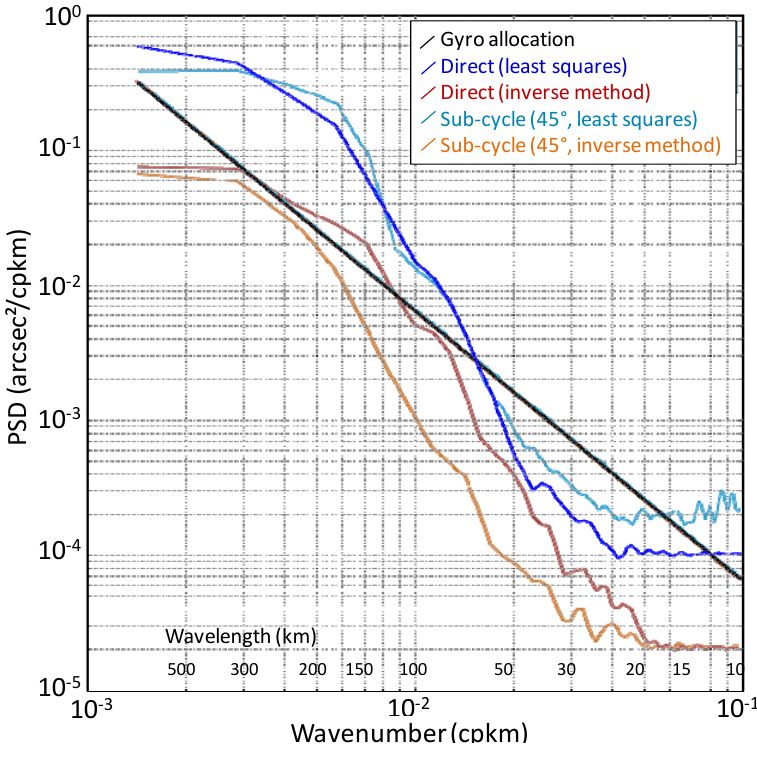
Figure 11. Usage of nadir altimetry and inverse methods to mitigate leakage of oceanic variability in roll. The dark blue PSD shows how much ocean variability is absorbed as apparent roll when unweighted least squares and the total topography are used in the direct method, and the red PSD shows the same results with an inverse method and a nadir constellation proxy. The cyan PSD shows how much ocean variability is absorbed as apparent roll when unweighted least squares and the total topography are used in the sub-cycle method (latitude of 45°), and the orange PSD shows the same result with an inverse method and a nadir constellation